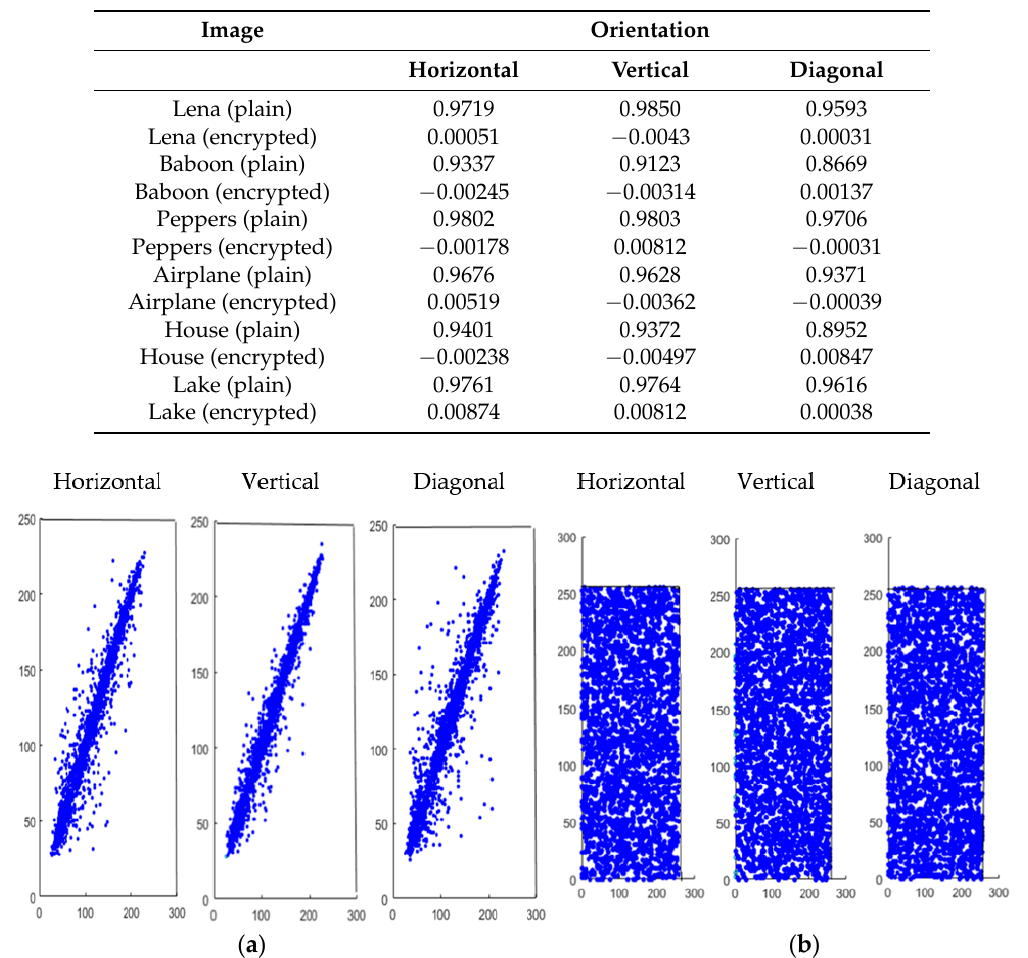
Figure 9. ( a ). Distribution of Lena image; ( b ). Distribution of encrypted Lena image.